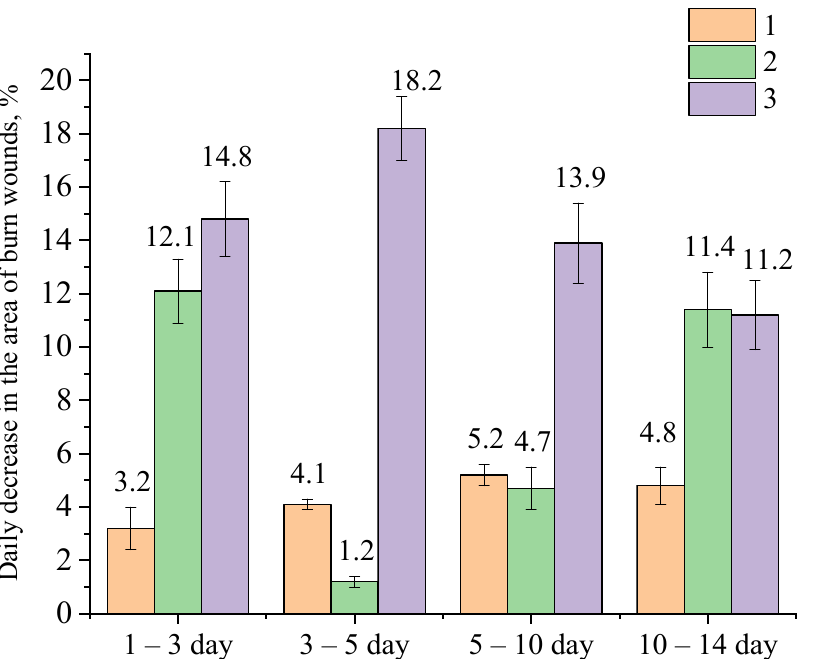
Figure 13. The rate of healing of burn wounds in experimental animals: 1—hydroxyethylcellulose gel; 2—gel of ZnO MPs and hydroxyethylcellulose; 3—gel of ZnO NPs modified with hydroxyethylcellulose.